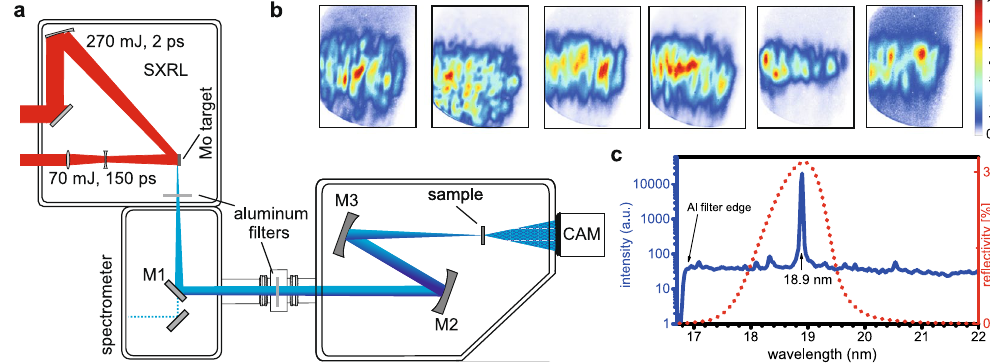
Figure 1. Experimental layout and SXRL properties. ( a ) The SXRL radiation is generated using a molybdenum target. The plasma is created by a long pre-pulse (70 mJ, 150 ps). The main pulse (270 mJ, 2 ps) prepares the population inversion in the highly excited nickel-like ions. Aluminium filters (500 nm thickness in total) suppress infrared stray light. Two curved mirrors (M2 & M3) reimage the light onto the sample and demagnify it by a factor of two. A soft X-ray sensitive CCD (CAM, ANDOR model iKon L) captures the far-field diffraction pattern of the sample. ( b ) Typical far-field modes comprising of single SXRL shots measured with the sample removed. ( c ) Typical Mo SXRL spectrum peaked at 18.9 nm (blue line) and combined reflectivity of the multilayer mirrors (M1, M2 and M3, red dotted